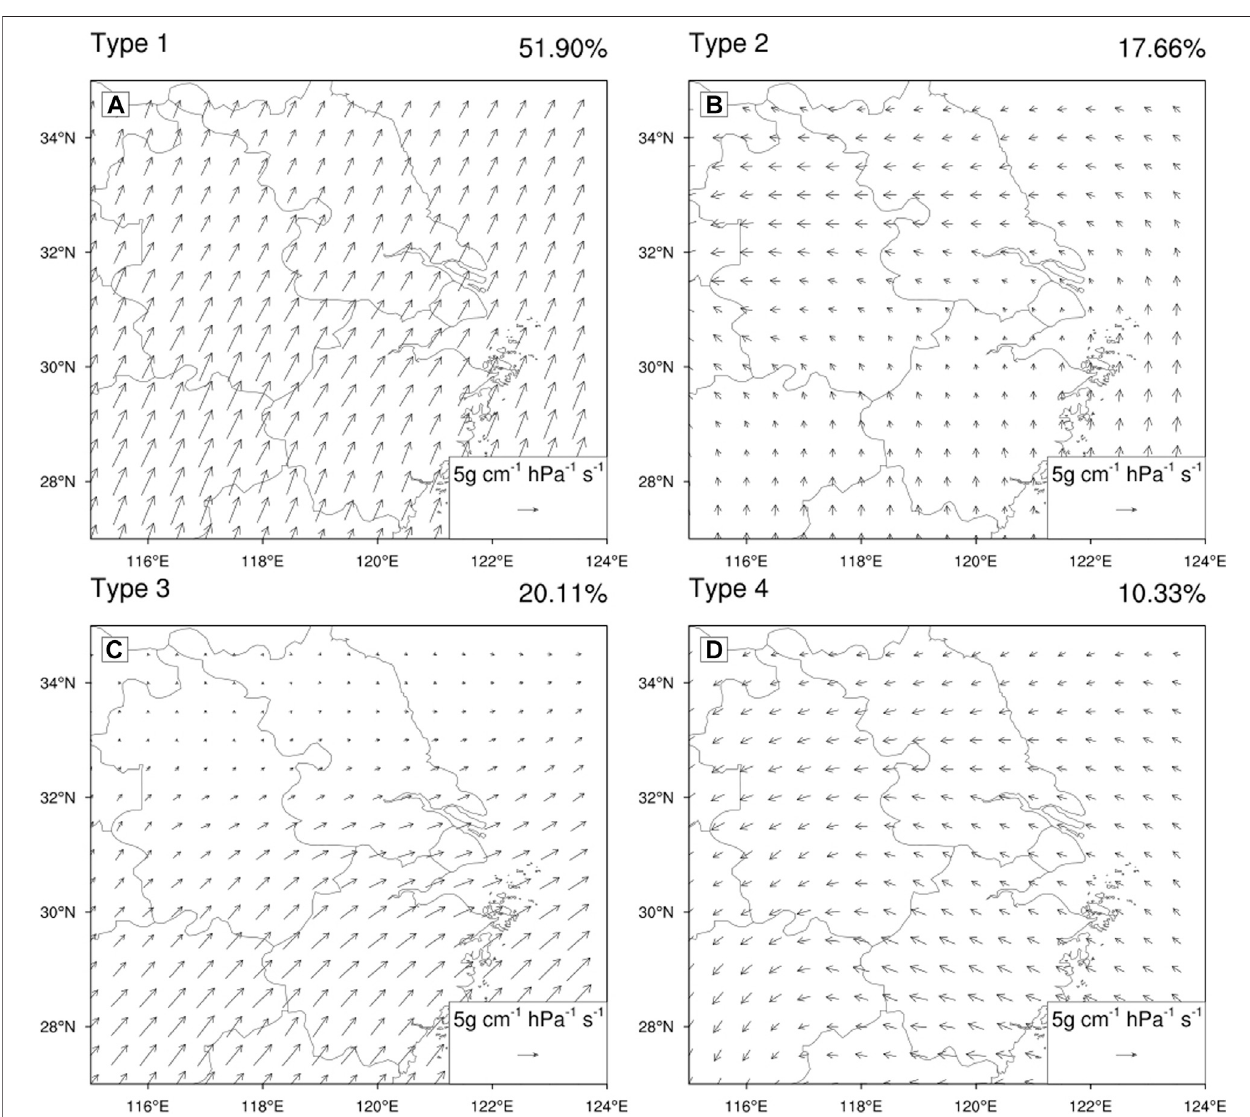
Frontiers in Environmental Science |